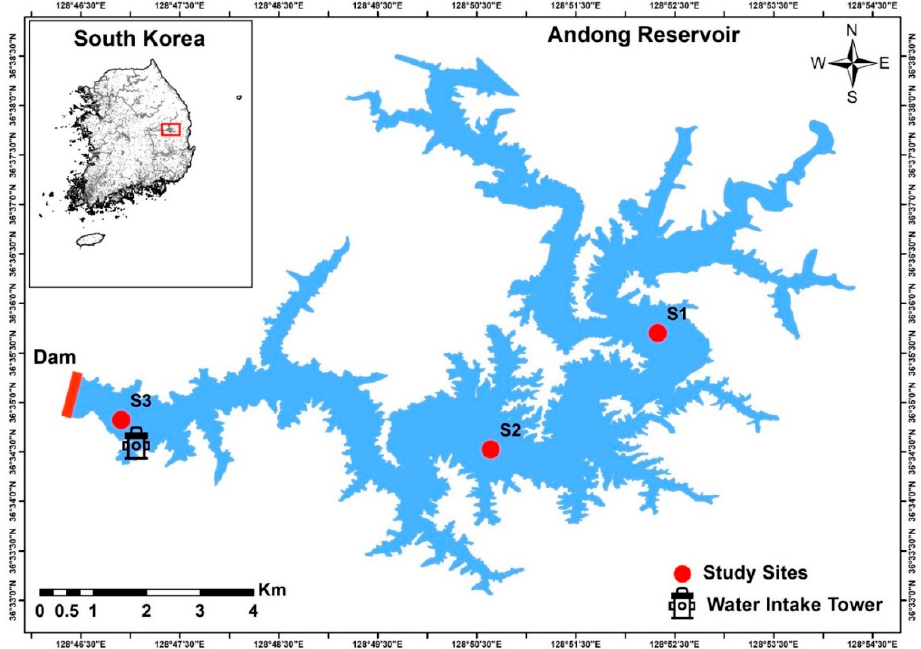
Figure 1. Map of study area map showing sampling sites in Andong Reservoir, South Korea.